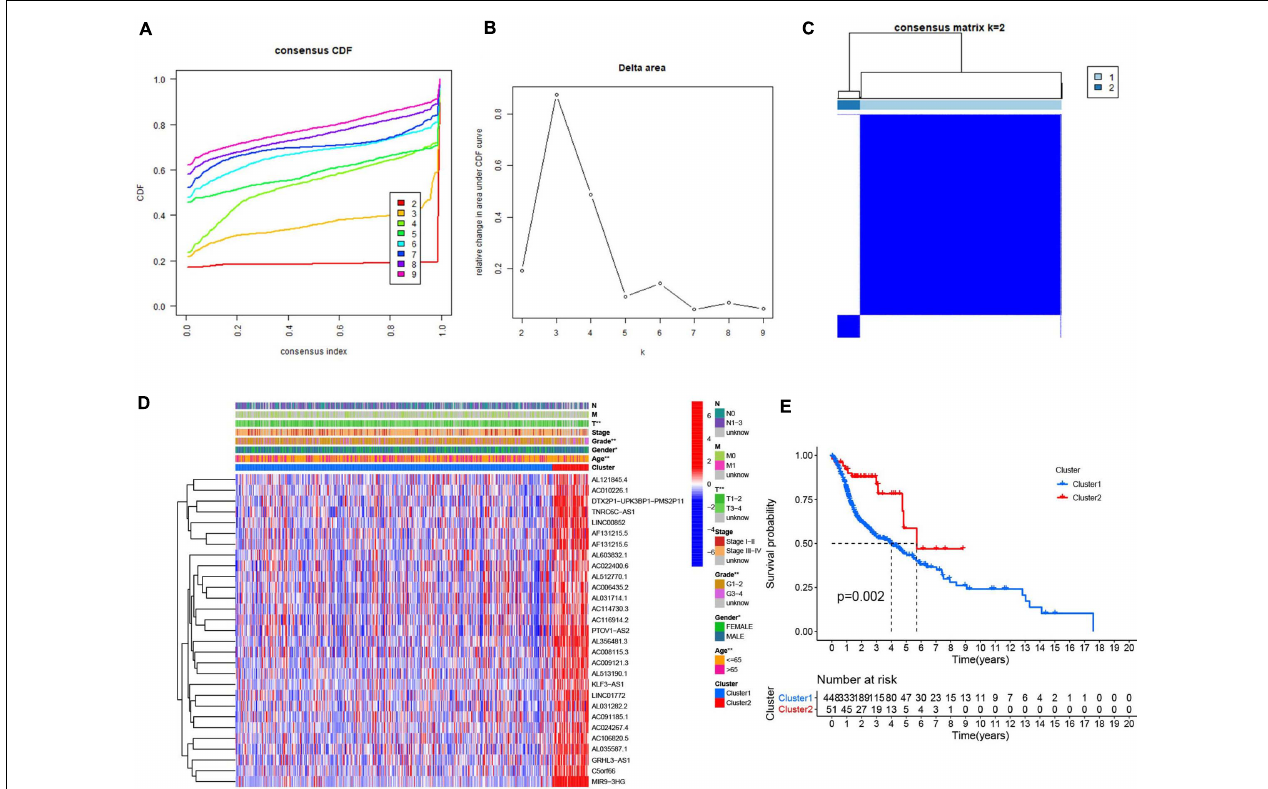
FIGURE 4 | Association between the m 6 A RNA methylation-related IncRNAs and clinicopathological and prognostic features of the HNSCC patients. (A) Consensus clustering model with cumulative distribution function (CDF) for k = 2–9 (k means cluster count). (B) Relative change in area under the CDF curve for k = 2–9. (C) The Cancer Genome Atlas (TCGA) HNSCC cohort was classified into two clusters with k = 2. (D) The correlation of the two clusters with clinicopathologic features was visualized by heatmap. P < 0.05 ("*"), P < 0.01 ("**"). (E) The overall survival of HNSCC patients in the two clusters was calculated by Kaplan-Meier